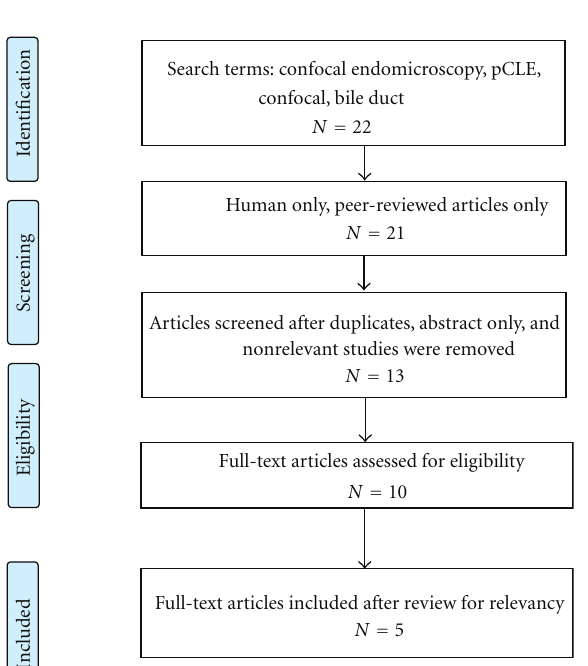
Figure 1: Literature review search